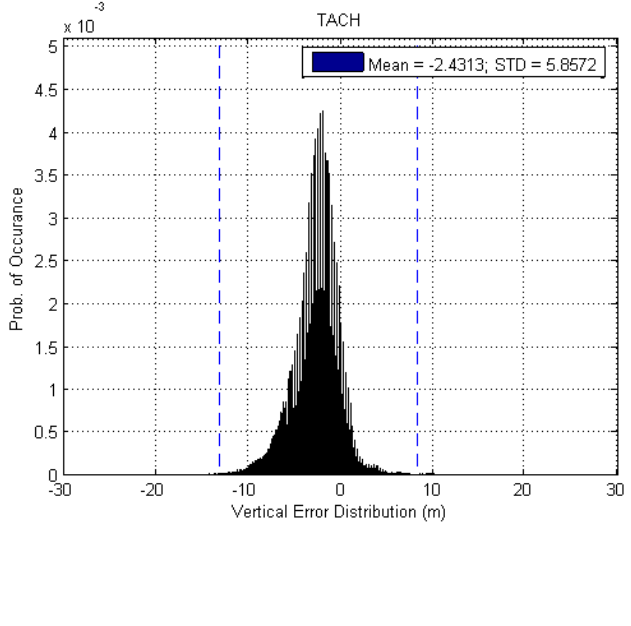
Figure 22. The vertical positioning error and 95% error bound in Taipei FIR (3